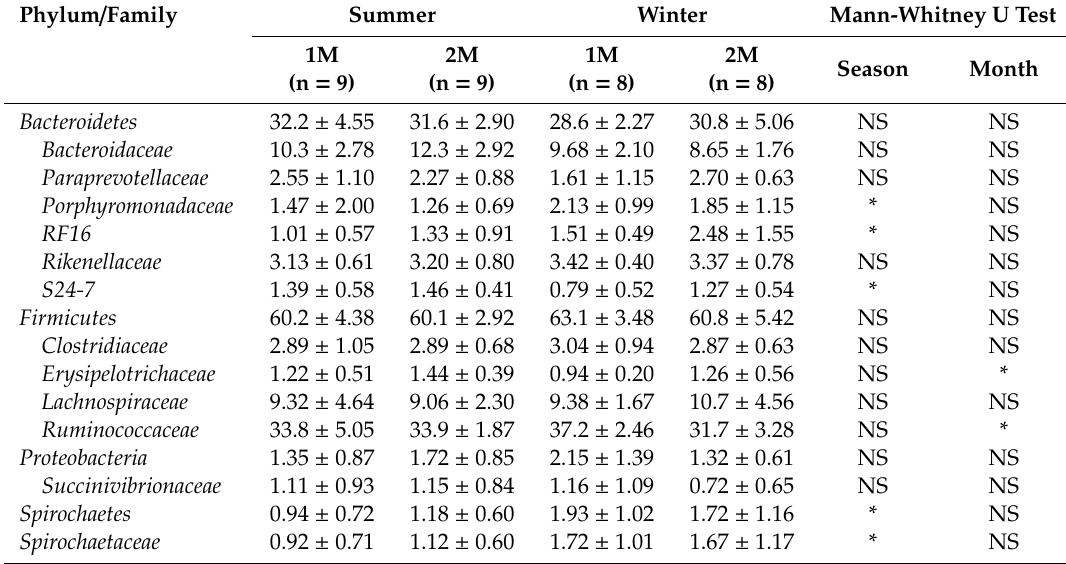
Table 3. Relative abundance (%) of fecal microbiota of the dairy cows examined at one and two months postpartum during the two seasons.